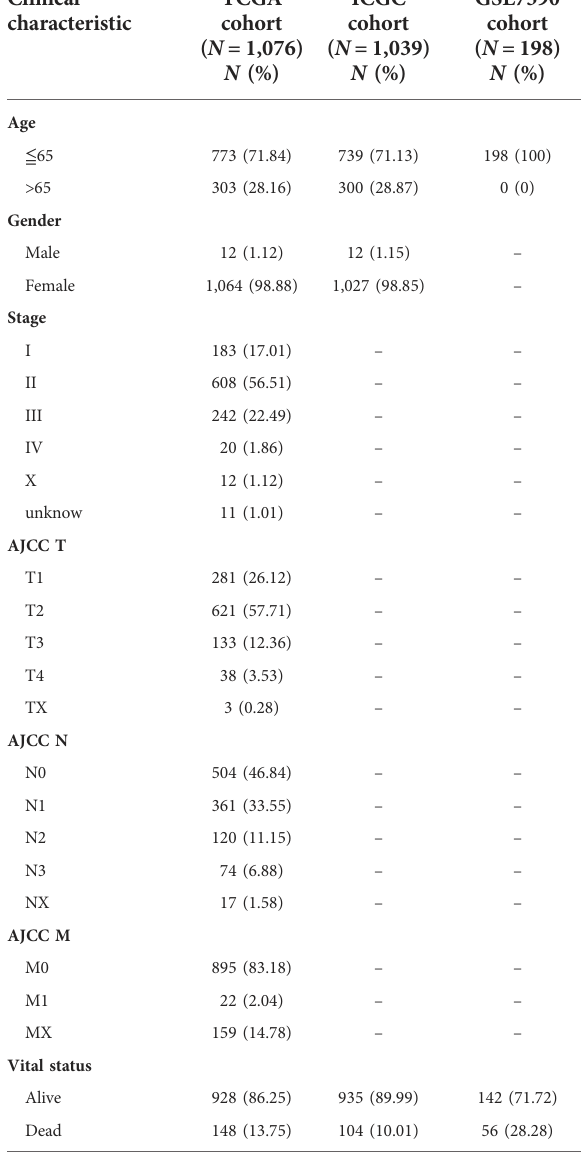
TABLE 1 Clinicopathological parameters of patients with BRCA in the study. Clinical